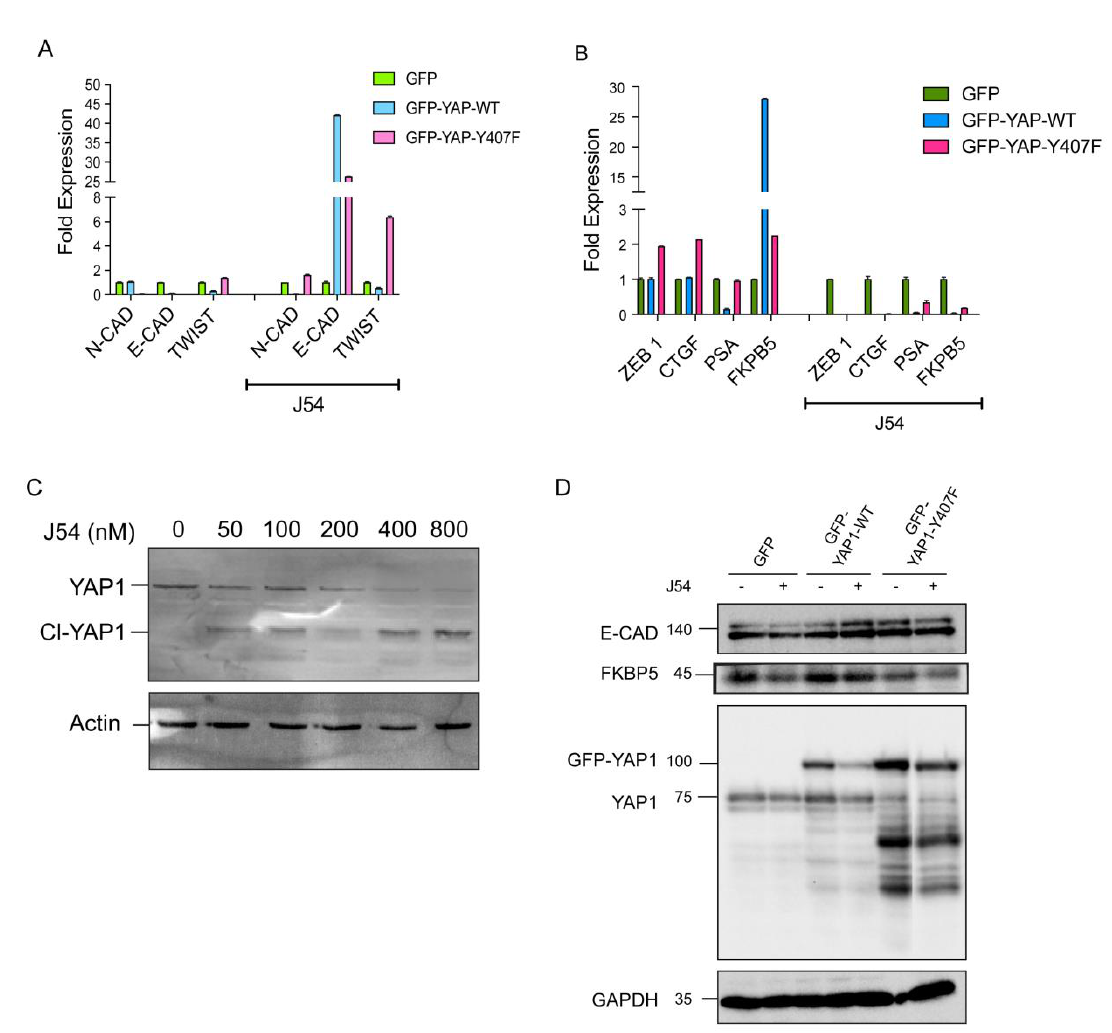
Figure 4. Changes in EMT and AR driving genes were reversed by J54 in LNCaP cells overexpressing GFP-YAP1. ( A ) Expression of key EMT genes in LNCaP cells overexpressing the GFP-YAP1-WT and Y407F mutant. Relative level of mRNA is shown for N-CAD, E-CAD and Twist genes treated with or without J54 (10 µ M, 24h). ( B ) Same experiment as ( A ) was performed but AR target genes (FKBP5 and PSA) along with CTGF and ZEB1 were tested. ( C ) As previously reported [9], J54 results in the degradation of full-length YAP1 and the accumulation of a cleavage product (Cl-YAP1), through a time and dose-dependent mechanism due to loss of Y407 phosphorylation and resultant destabilization. ( D ) Accumulation of E-CAD, a marker of EMT reversal, was seen in YAP-WT-overexpressing cells treated with J54. This also resulted in the degradation of GFP-YAP1-WT, but not the GFP-YAP-Y407F, which was instead constitutively degraded. Two-way ANOVA statistical tests were performed within each row, (column effect), and where differences among groups were present, they were found at p < 0.0001 (or less) level of significance.